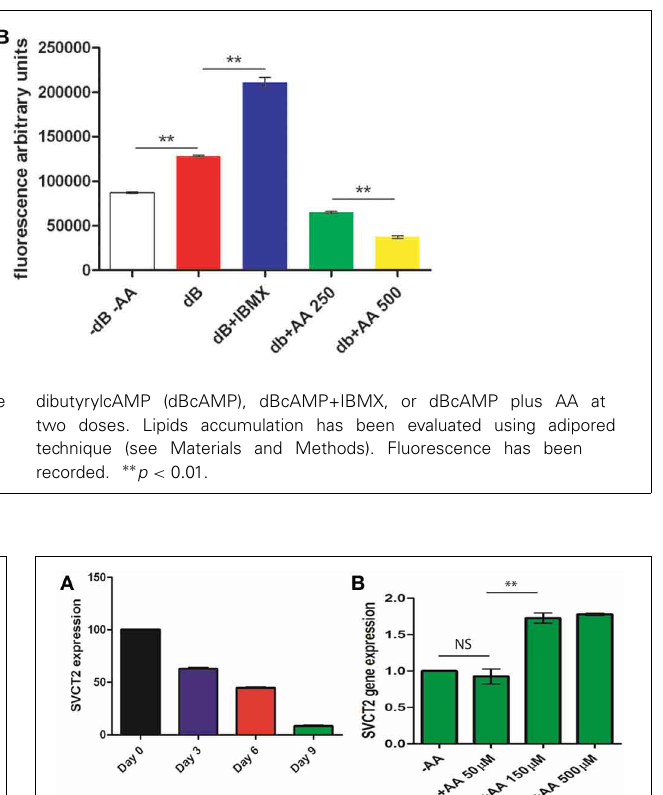
FIGURE 8 | Expression of SVCT2 during 3T3L1 differentiation. (A) Cells were cultured in a medium with IBMX, allowing full differentiation, without AA. RNAs are extracted after 3, 6, and 9 days of culture. Expression of SVCT2 is evaluated using qPCR and specific primers (see Table 1 ) (B) . Adipocytes have been cultured in a medium without IBMX, as described in Figure 3 , and with increasing concentrations of AA. Expression of SVCT2 was evaluated using qPCR. ∗∗ p < 0 .